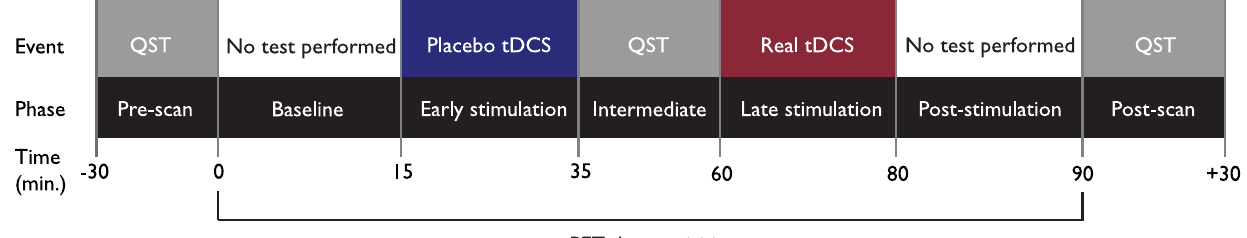
Figure 1. Experimental design used in the second PET scan. Placebo tDCS was applied during the early PET phase (15 to 35 min post-tracer administration) and real tDCS during the late PET phase (60 to 80 min). QST was performed before the PET, in the period between placebo and real tDCS and immediately after the PET.